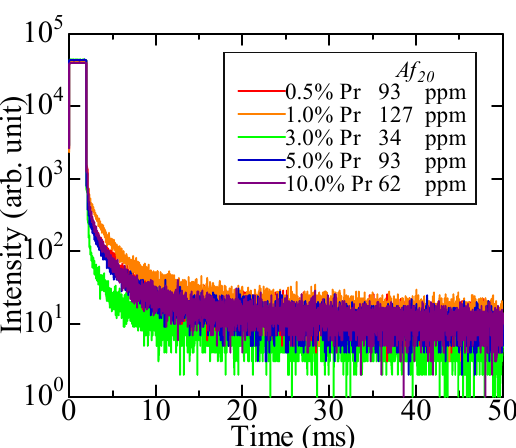
Figure 8. Afterglow time profile of Pr-doped LaPS samples.